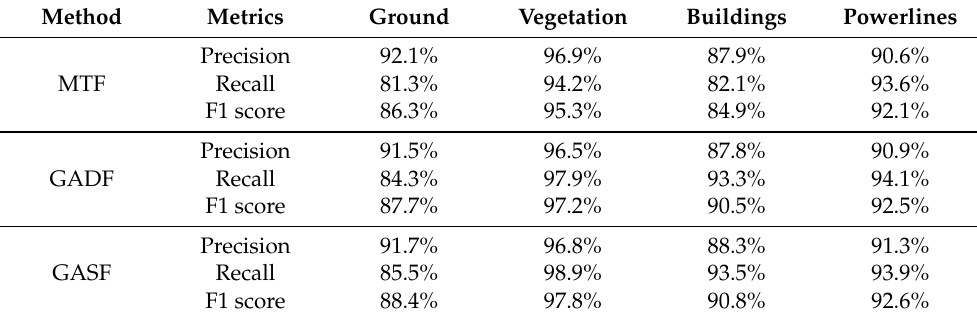
Table 1. Comparison of different methods used on the urban full waveform.